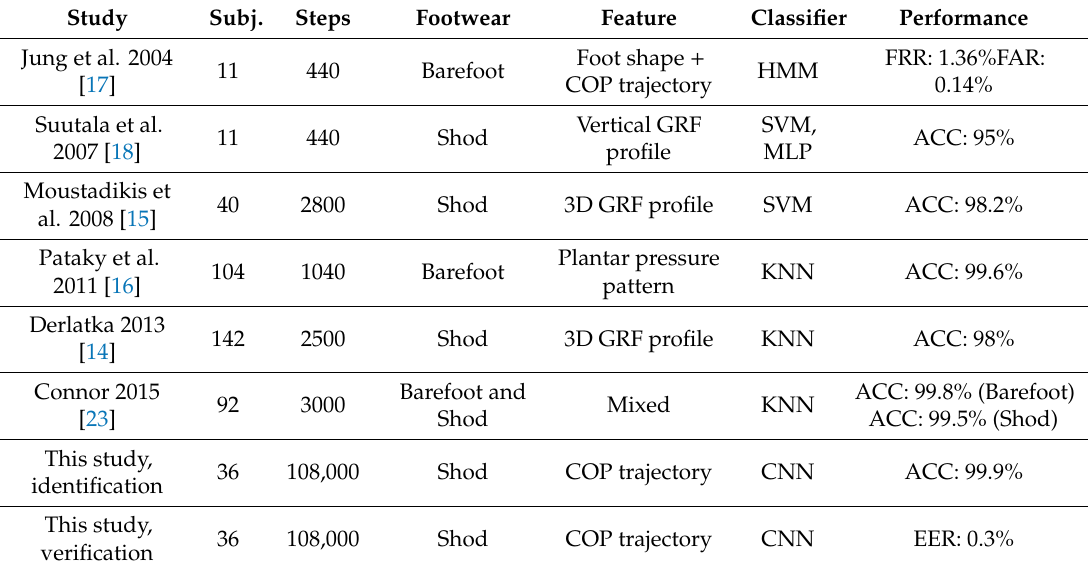
Table 4. Summary of representative studies in footstep